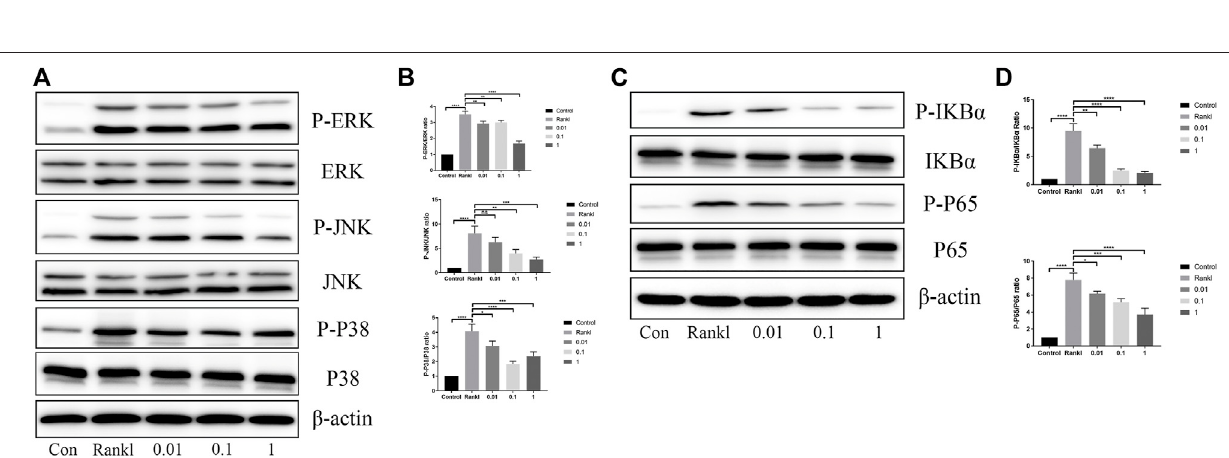
Frontiers in Pharmacology |